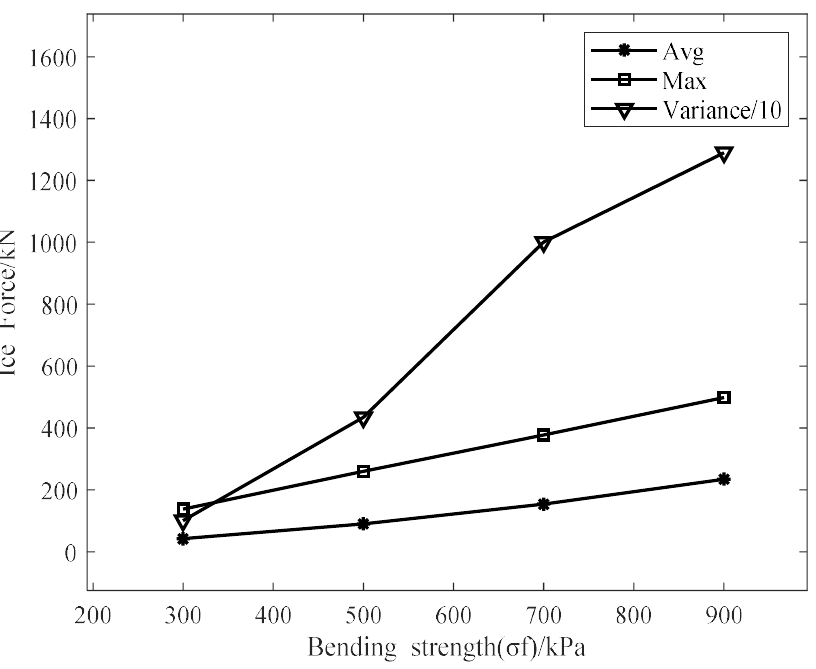
Figure 21. Change trend of variance and ice force with bending strength ( σ f ).